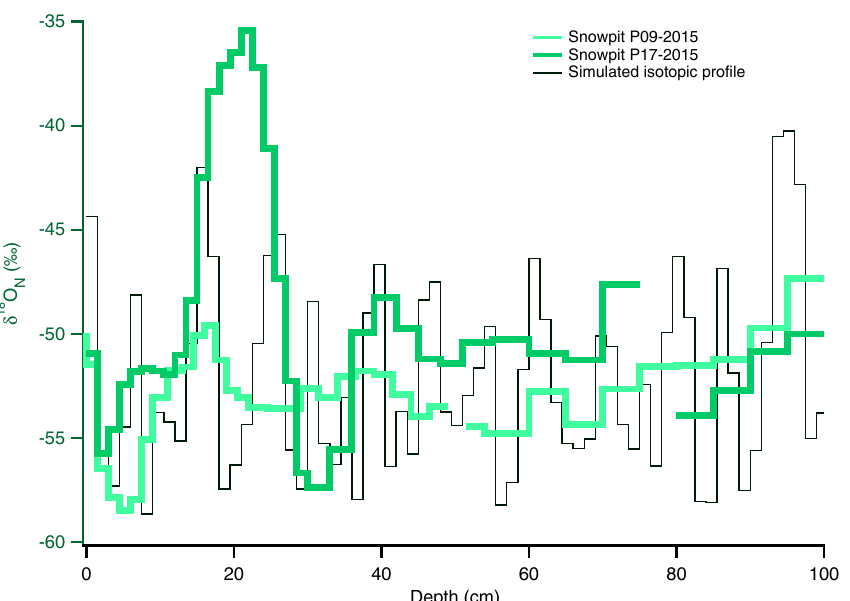
Figure 9. Comparison of two snow pit isotopic composition profiles (green lines) in January 2015 (see Table 3), with a simulated isotopic composition profile from accumulation of precipitation (dark green thin line). Table 4. Mean “apparent cycle”; length obtained by manual counting of maxima from the isotopic composition profiles from the pits. Sites are sorted by accumulation in snow equivalent (calculated using an average snow density of 350kgm − 3 ). Accumulation Spacing between Spacing between Number Length of Finest Site (cm of snow) max of δ 18 O N (cm) max of δD N (cm) of pits the pits (m) resolution